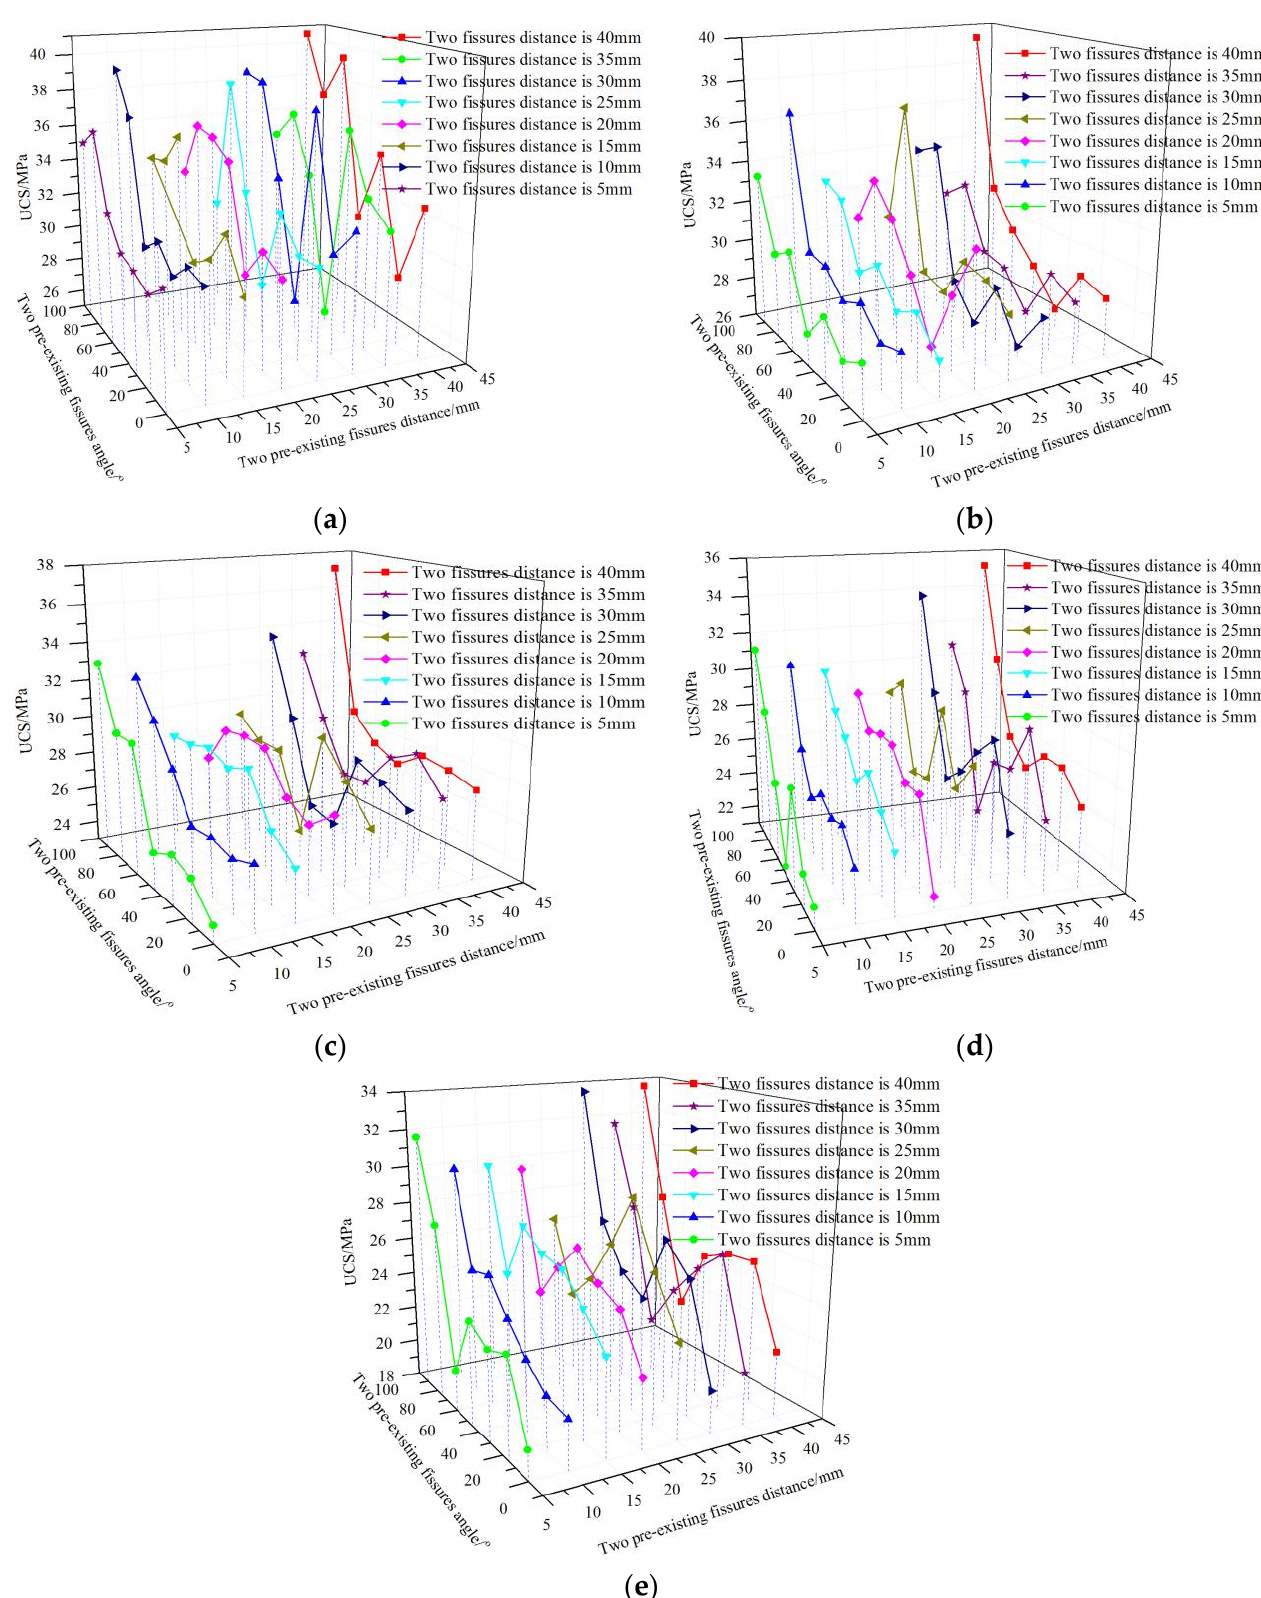
Figure 5. UCS of rock-like materials with variations in the preexisting fissure angle. ( a ) Preexisting fissure length is 10 mm; ( b ) 20 mm; ( c ) 30 mm; ( d ) 40 mm; and ( e ) 50 mm.